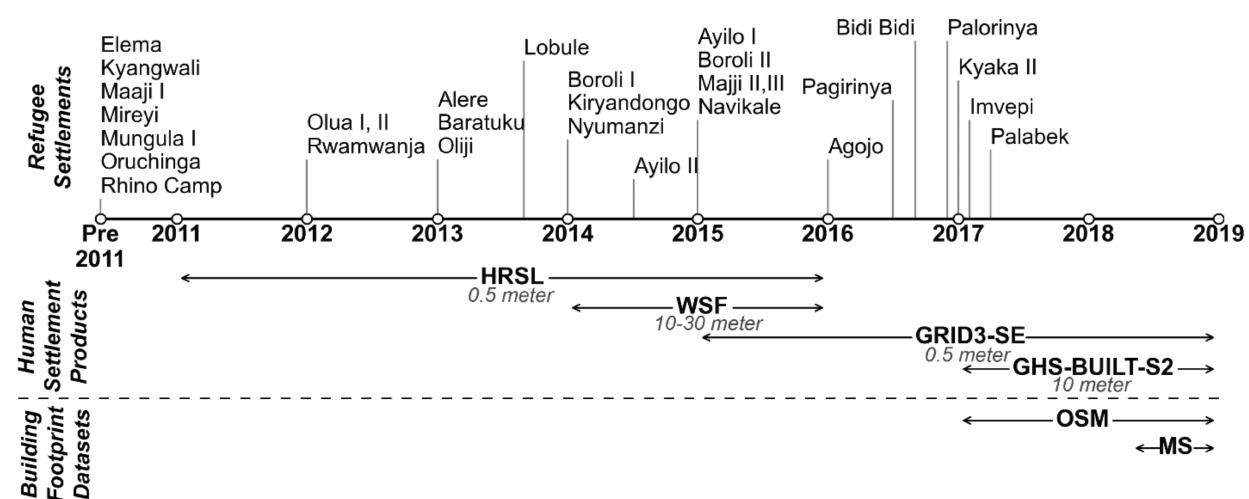
Figure 6. Timelines of refugee settlement establishment dates and periods of satellite imagery used to generate human settlement products and building footprint datasets. HRSL, High Resolution Settlement Layer; WSF, World Settlement Footprint; GRID3-SE, Geo-Referenced Infrastructure and Demographic Data for Development settlement extent data; GHS-BUILT-S2, Global Human Settlement Layer with Sentinel 2; OSM, OpenStreetMap; MS,